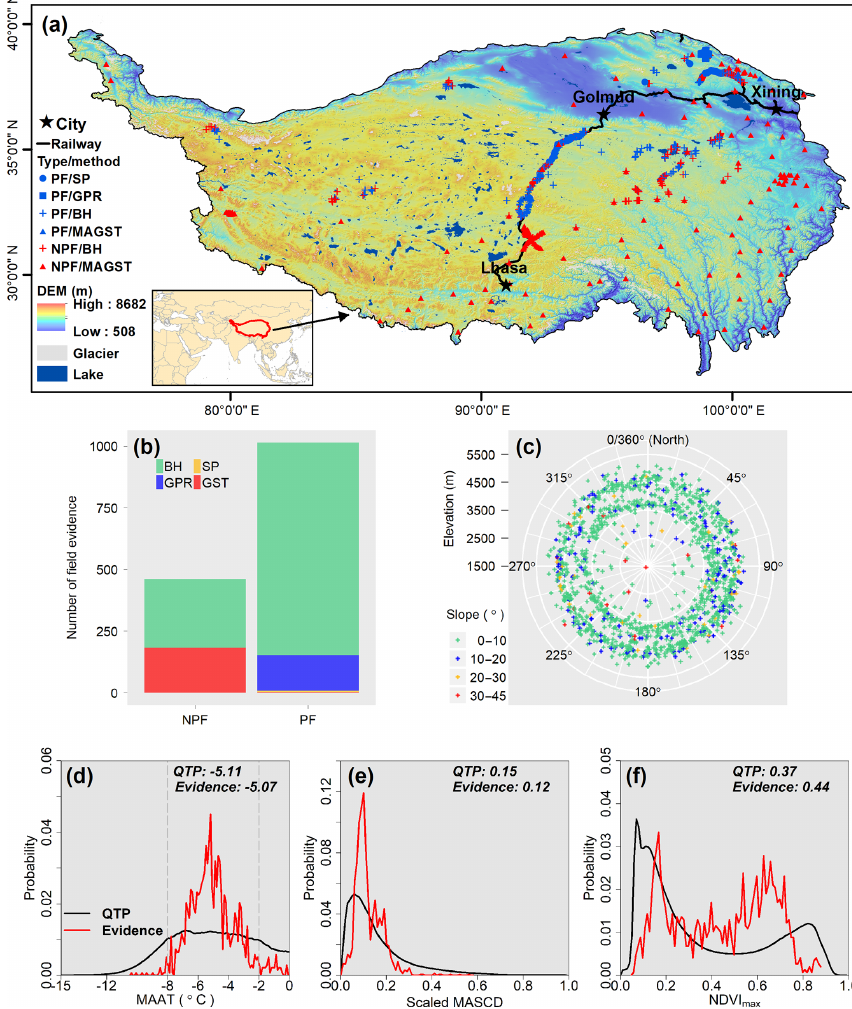
Figure 1. (a) The location of the QTP, and the distribution of evidence of in situ permafrost presence (PF) or absence (NPF) over the QTP, superimposed on the background of the digital elevation model (DEM) with a spatial resolution of 30arcsec. (b) Number of field evidence located in NPF and PF regions. SP means soil pit, GPR refers to ground-penetrating radar, BH stands field evidence measured by borehole drilling, and MAGST is the mean annual ground surface temperature. (c) Distribution of field evidence in terms of elevation (radius), slope (coloured), and aspect (0 / 360 ◦ represents north). Distributions of (d) mean annual air temperature (MAAT), (e) scaled mean annual snow cover days (MASCD), and (f) annual maximum NDVI (NDVI max ) for field evidence (red line) compared to the entire QTP (black line). Numbers in (d) , (e) , and (f) are mean values. Only the sites with MAAT < 0 ◦ C, which is the precondition for permafrost presence, are present in (d)